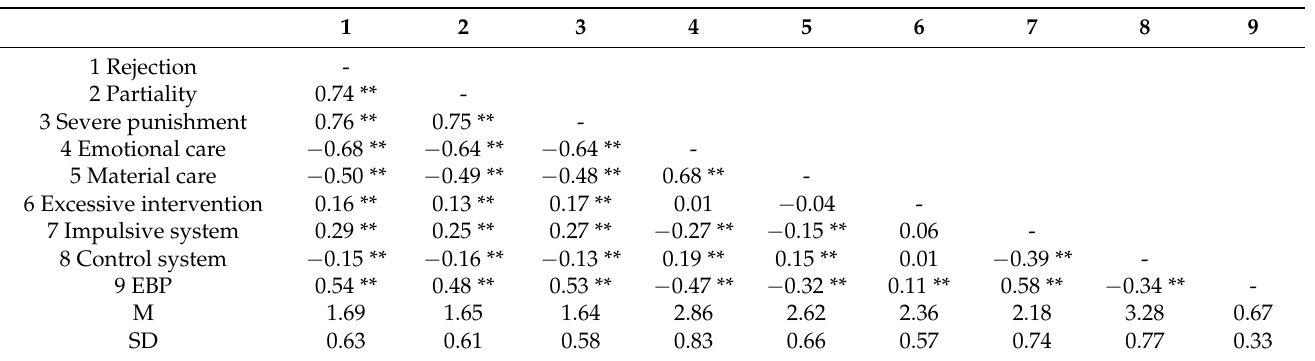
Table 1. Descriptive statistics and correlations.